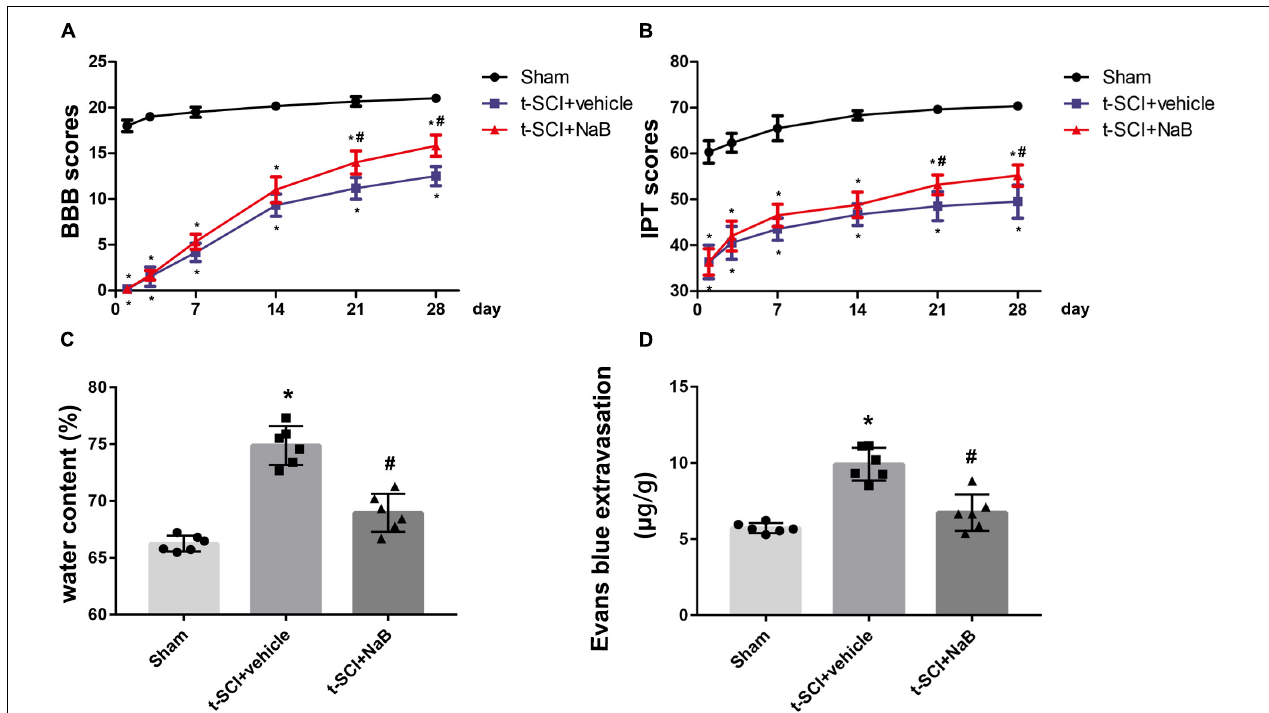
FIGURE 7 | BBB and IPT scores were significantly decreased after t-SCI at each time point. Treatment with NaB significantly increased the BBB and IPT scores at days 21 and 28 post-injury (A,B) . N = 6 for each group. Data is expressed as mean ± SD and analyzed by two-way ANOVA and Bonferroni’s post hoc multiple comparisons test. At 24 h post-injury, treatment with NaB significantly reduced the SCWC (C) and EB extravasation (D) , which was increased after t-SCI. N = 6 for each group. Data is expressed as mean ± SD and analyzed by one-way ANOVA and Bonferroni’s post hoc multiple comparisons test. ∗ p < 0.05 versus sham; # p < 0.05 versus t-SCI +